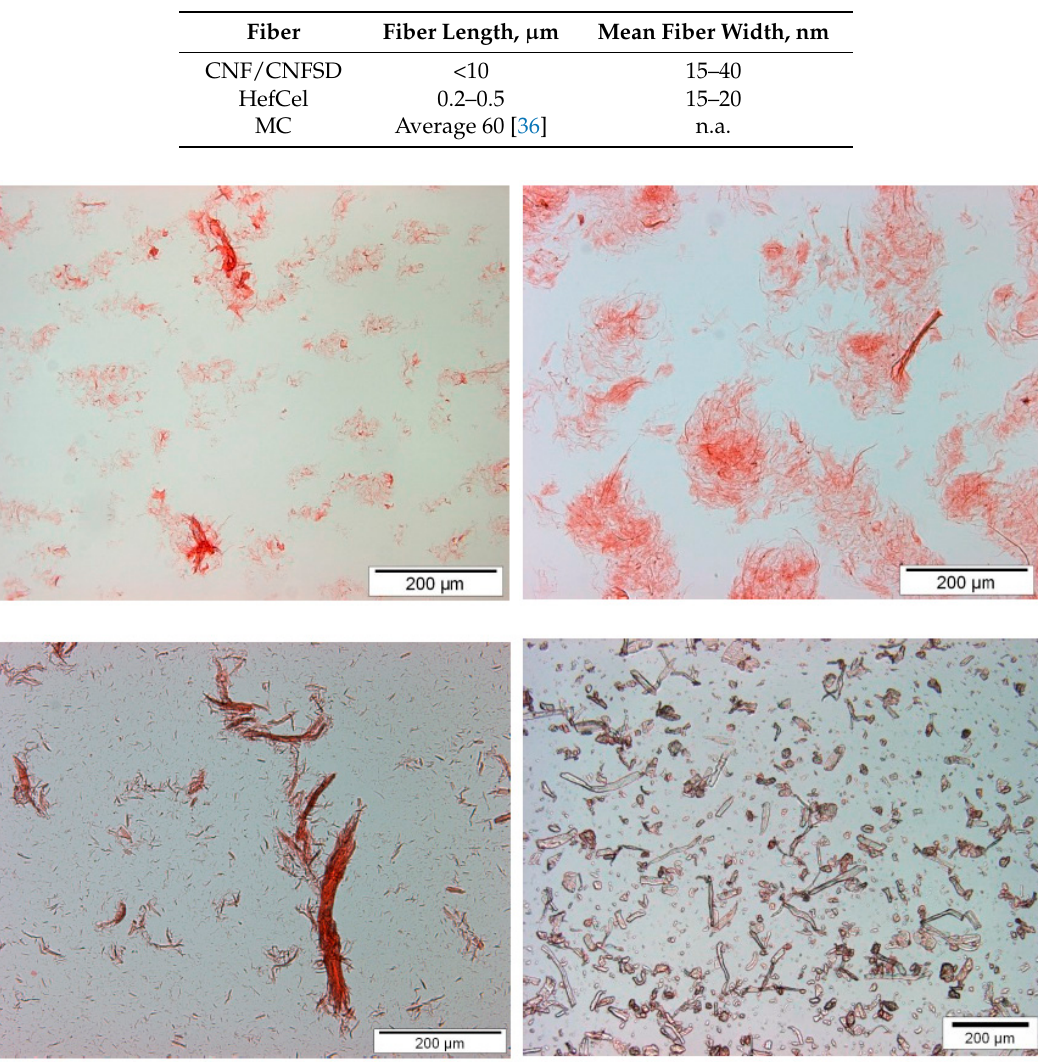
Table 1. Fiber dimension of cellulosic materials used in PLA composites.